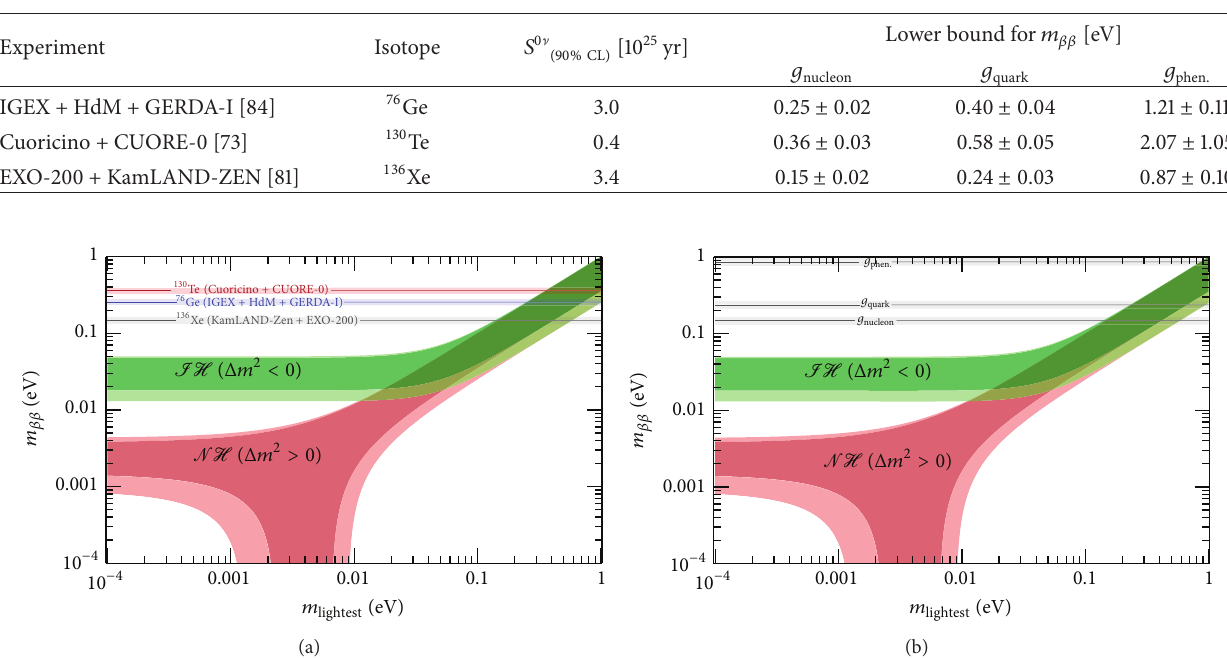
. (b) Combined nucleon